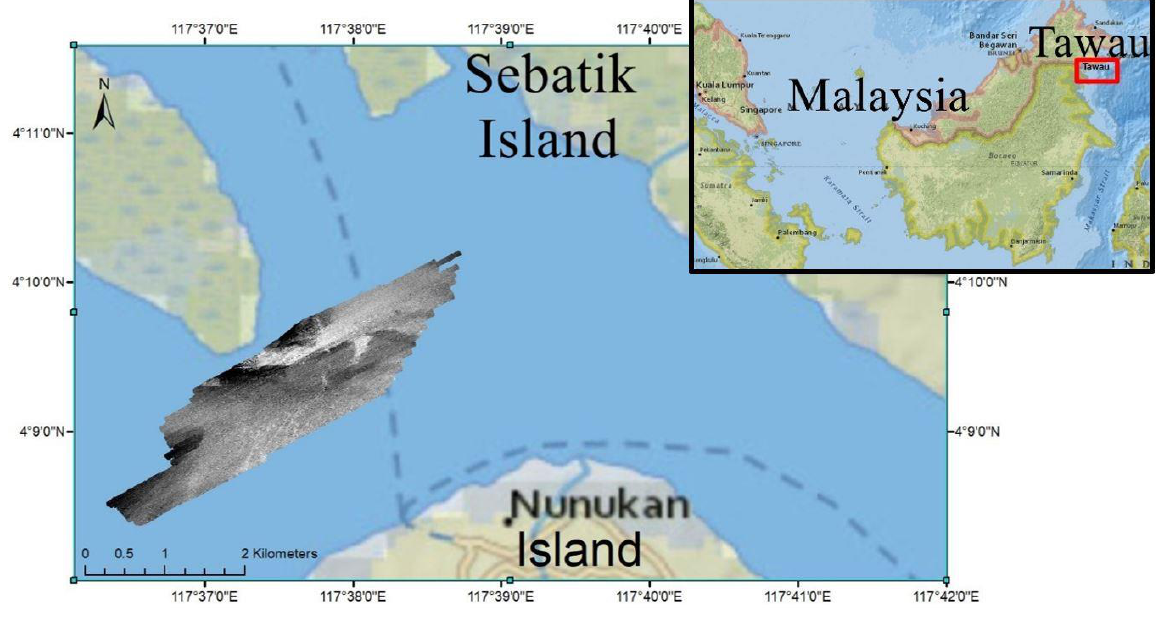
Figure 1: Location map of study area. The inset map shows the location of the study area relative to the location of